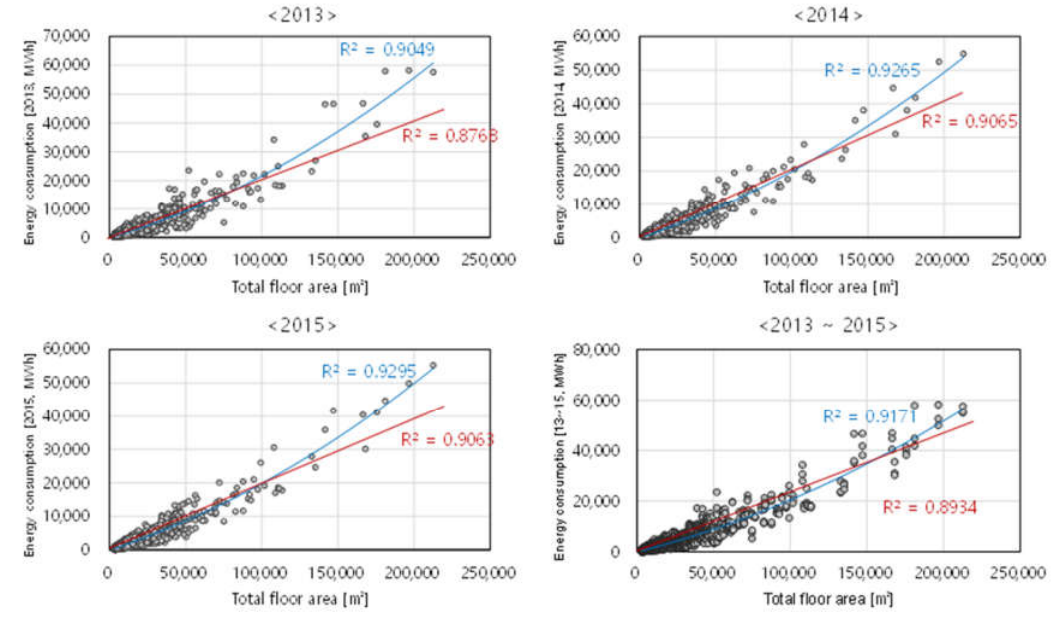
Figure 2. Di ff erence of coe ffi cient of determination between second-order polynomial regression and Figure 2. Difference of coefficient of determination between second-order polynomial regression and simple linear regression by simple linear regression by year.